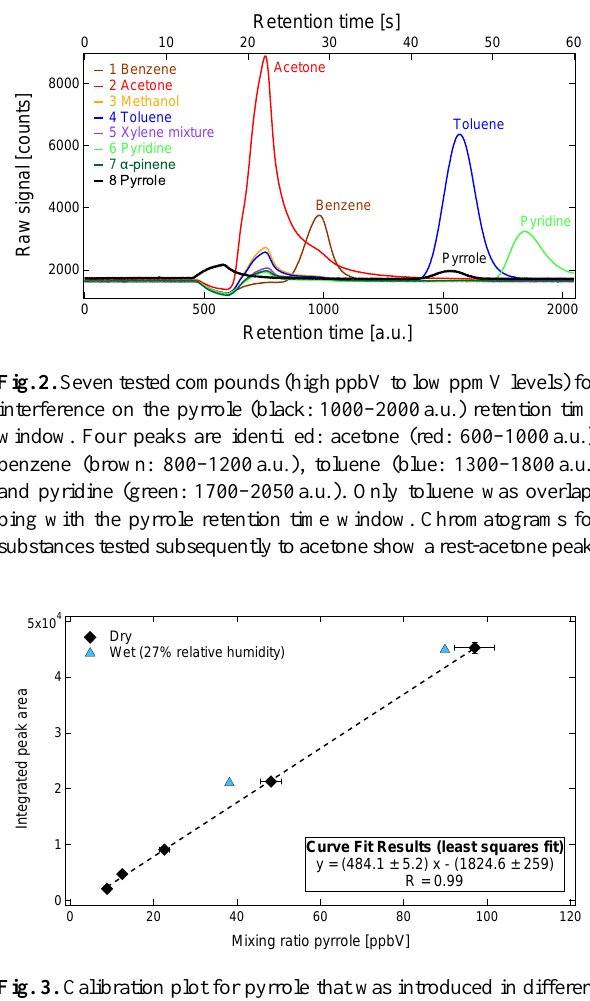
Curve Fit Results (least squares fit) y = (484.1 ± 5.2) x - (1824.6 ± 259) R = 0.99 120100806040200 Mixing ratio pyrrole [ppbV] Fig. 3. Calibration plot for pyrrole that was introduced in different mixing ratio levels and detected with the GC-PID. The peak area was monitored and peak area integration averages were used to re- ceive a calibration factor. Standard deviations of the averaged peak areas were less than 4%. Two points (blue) were monitored in hu- mid air and compared to dry results